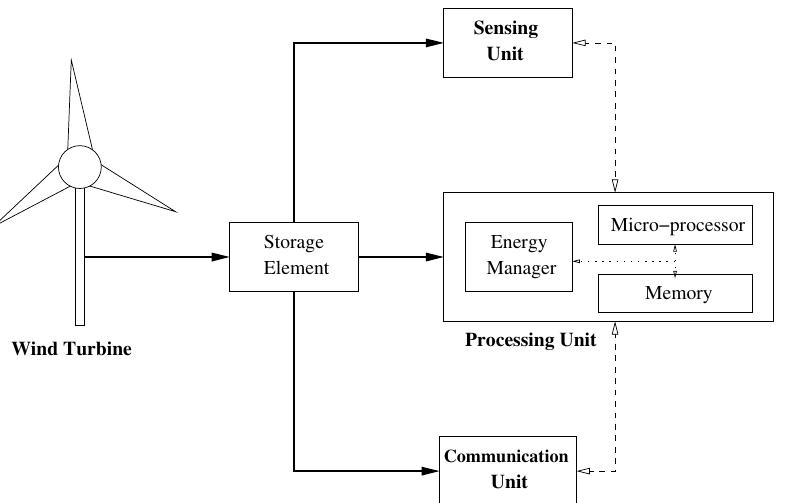
Figure 1. Block diagram of a wind-powered energy harvesting (EH) node. Solid (dotted) lines represent energy (data)